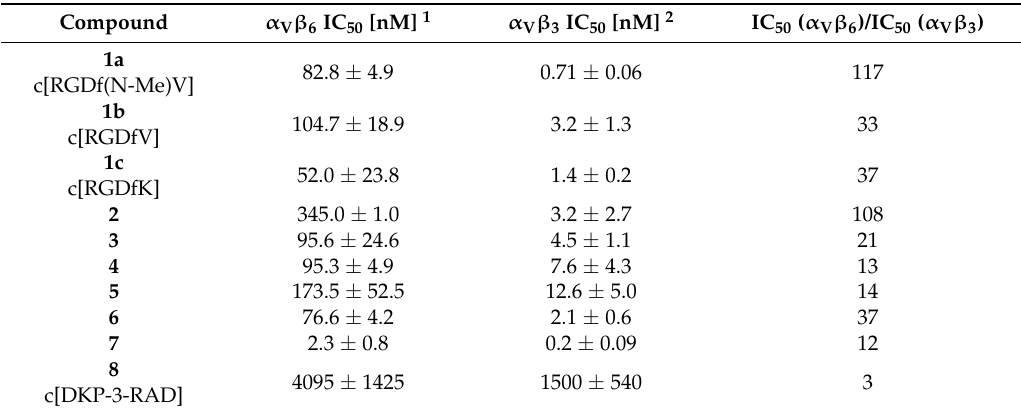
Table 1. Inhibition of biotinylated fibronectin binding to α V β 6 integrin compared with inhibition of biotinylated vitronectin binding to α V β 3